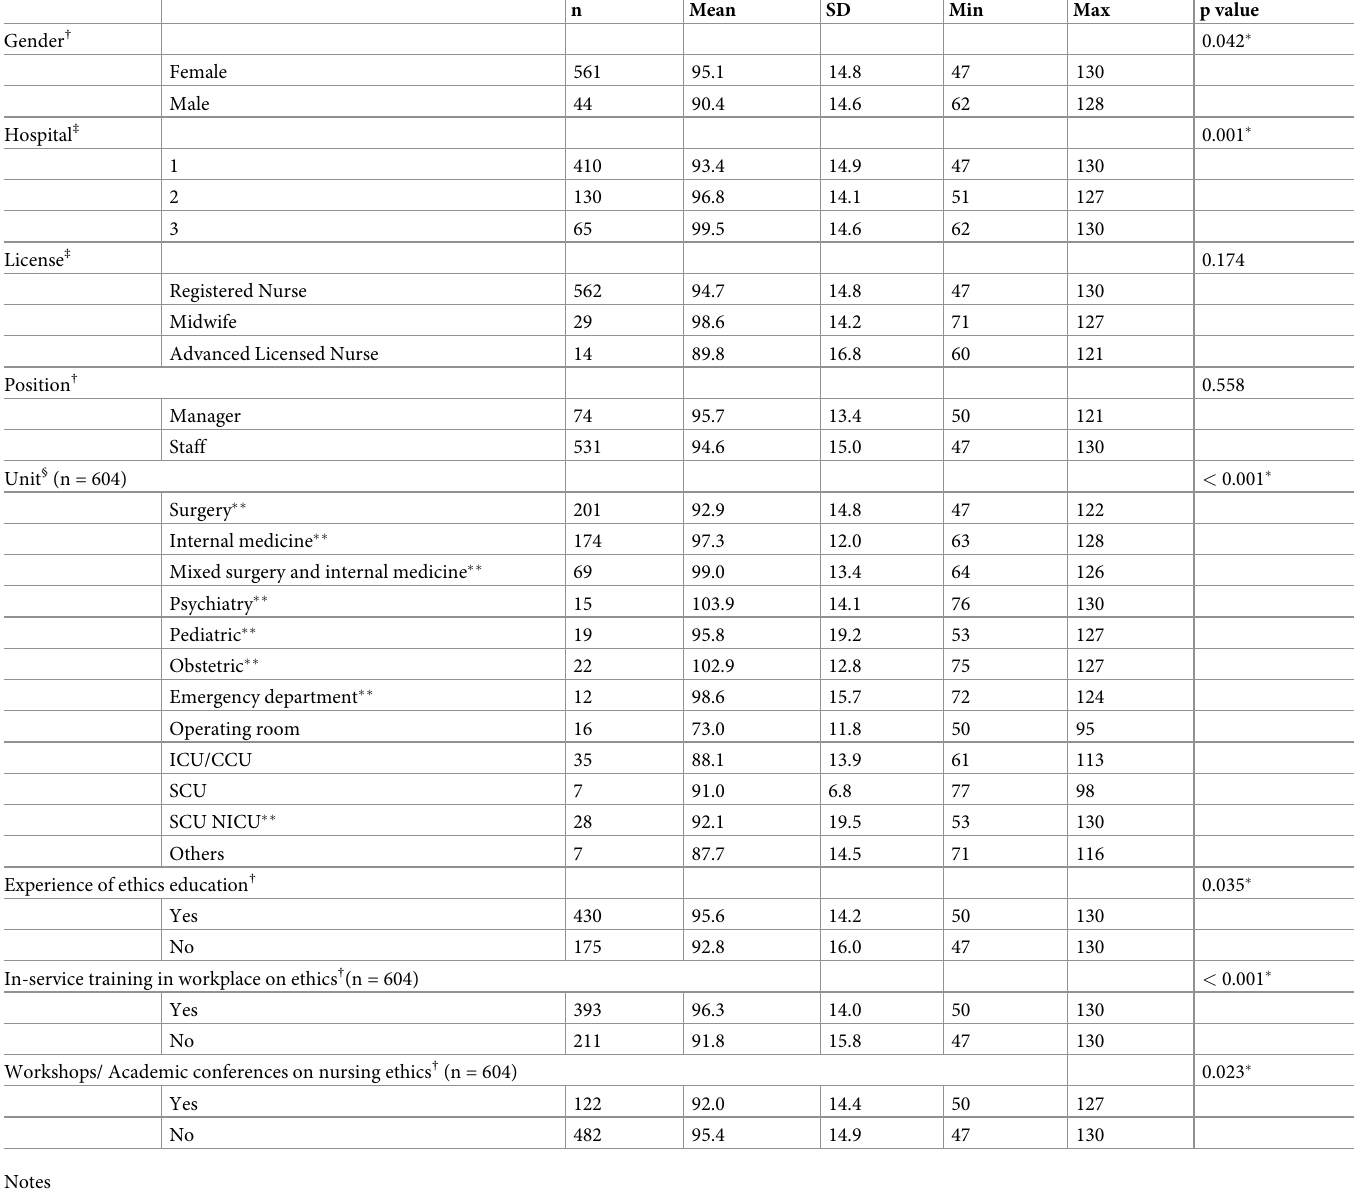
Table 3. Association between demographic variables and J-HECS26 total score (n =